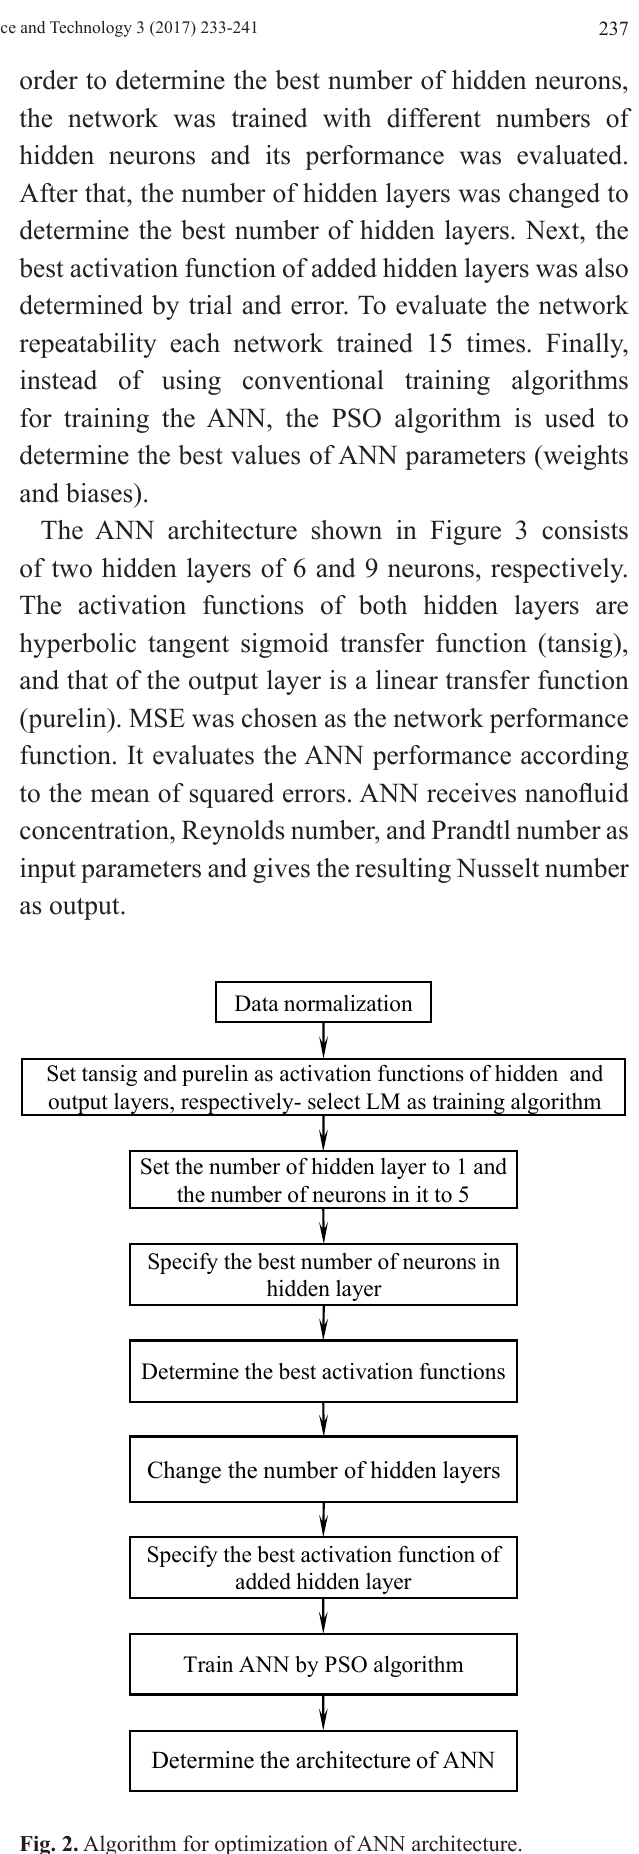
Fig. 2. Algorithm for optimization of ANN